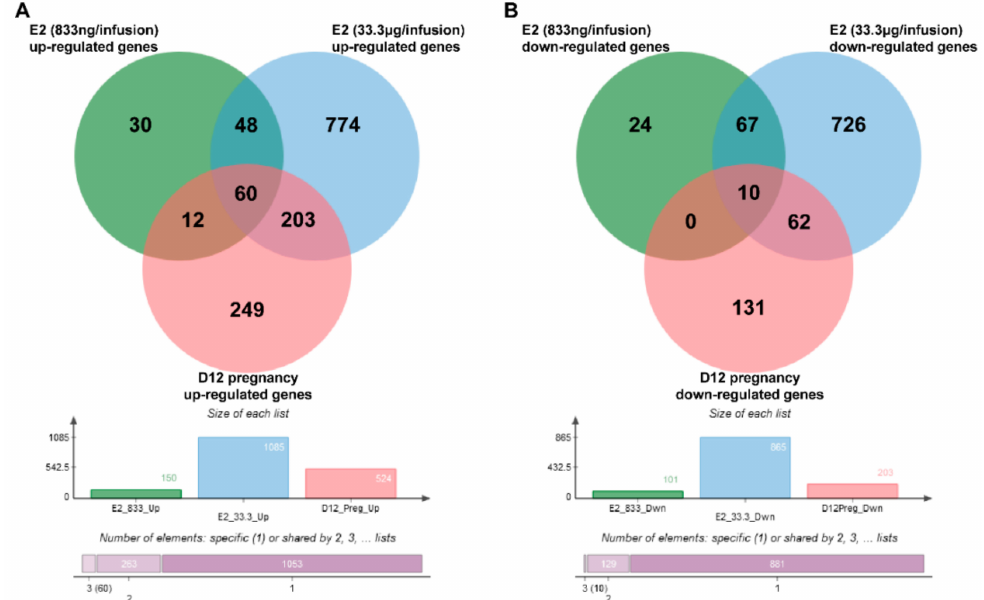
Figure 3. Venn diagrams of common, and group-specific up- ( A ) and down-regulated ( B ) genes. D12 pregnancy–endometrial samples collected on day 12 of pregnancy, E2 (833 ng / infusion) endometrial samples collected from uterine horns receiving 833 ng of E2 / infusion, E2 (33.3 µ g / infusion)—endometrial samples collected from uterine horns receiving 33.3 µ g of E2 / infusion. Complete lists of common and group-specific DEGs are presented in Supplementary Table